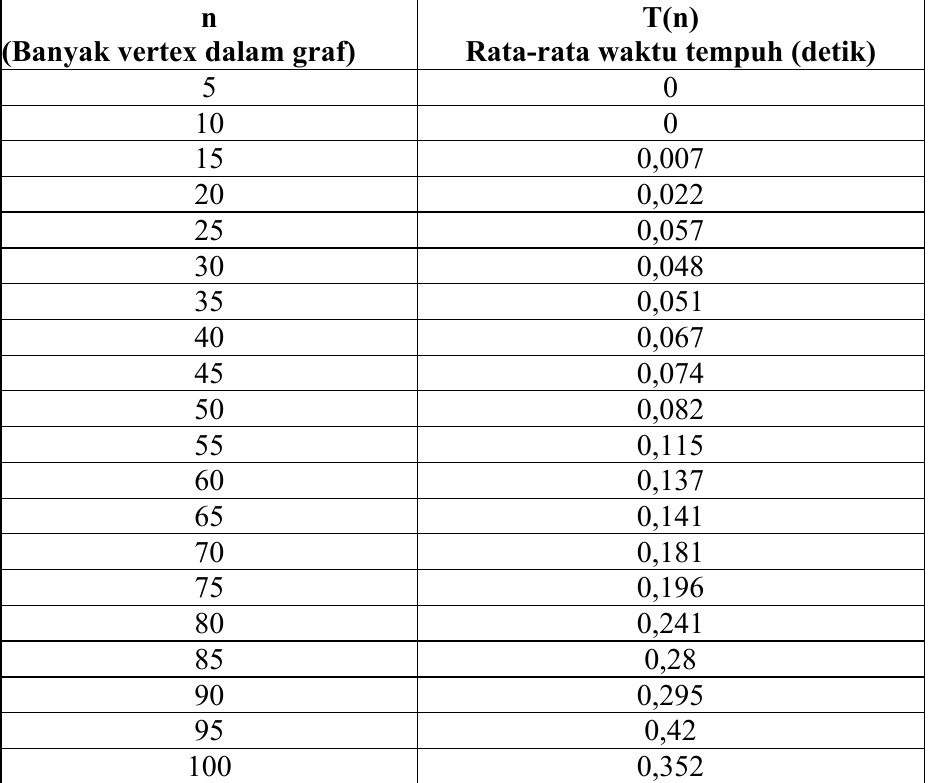
Table 3. Experimental data II Computer Processor 1.90 GHz, Cache 6 MB Intel@ Smart Cache, Bus Speed 5 GT/s, TDP 35 W, Max Turbo Frequency 2.70 GHz, Number of strands 4, Number of Cores